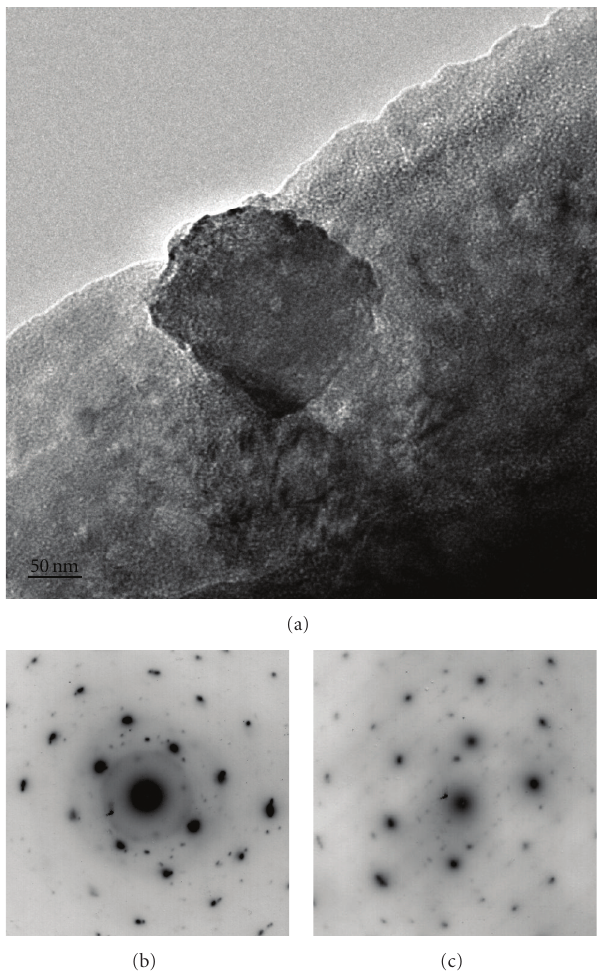
Figure 5: The TEM image and SAD patterns. (a) Bright field image; (b) SAD pattern of [001] zone axis; (c) SAD pattern of BCC [012] zone axis.